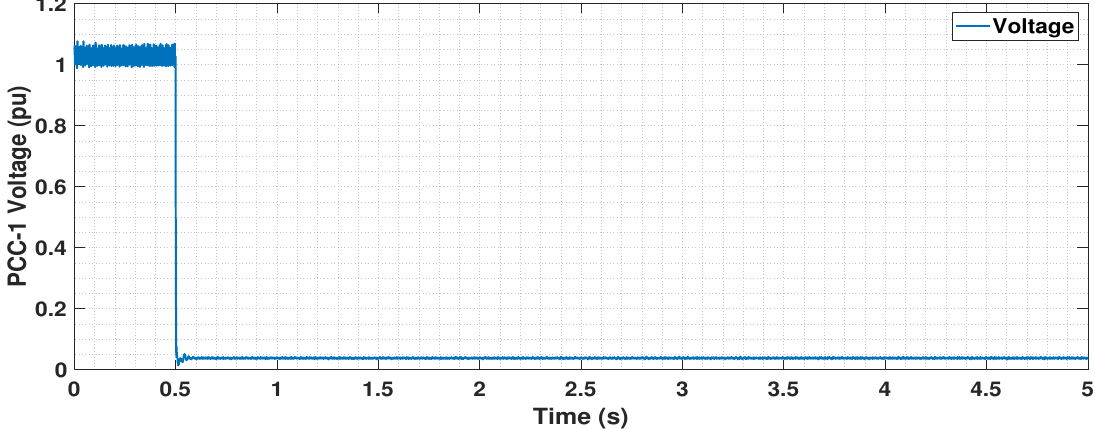
Figure 35. Voltage in p.u. at PCC-1 upon three-phase line to ground fault in the middle of